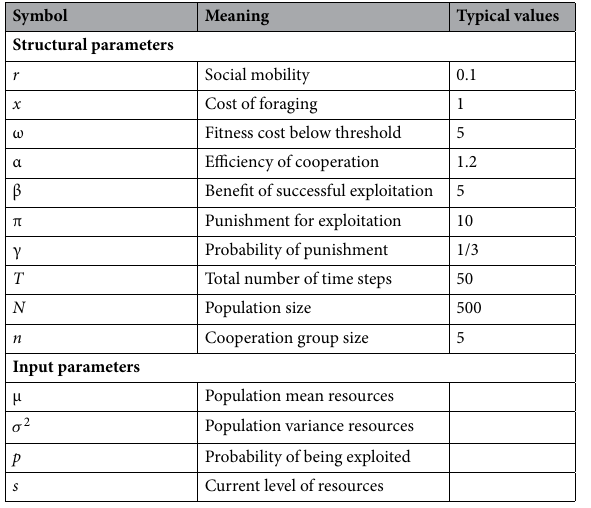
Table 1. Main parameters used in modelling and simulations, with default values for structural parameters where